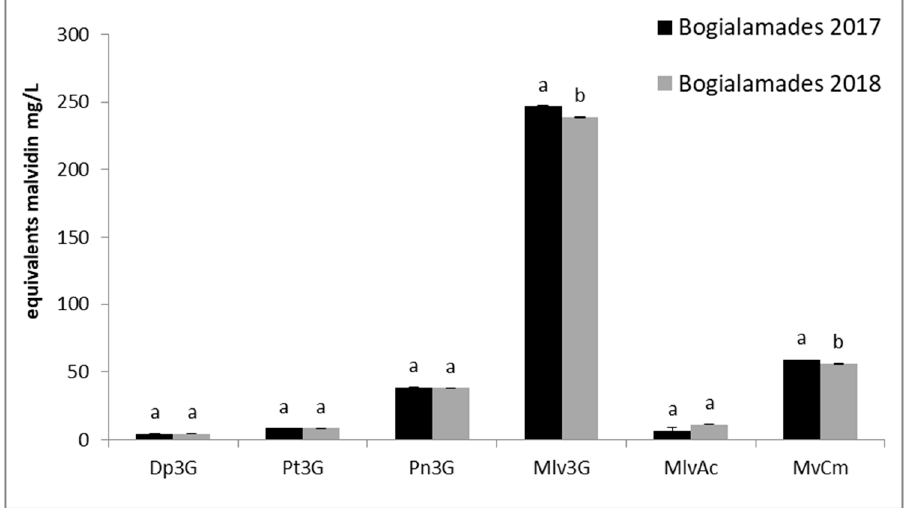
Figure 5. Individual anthocyanins evaluated by HPLC in “Bogialamades” wines. Abbreviations: Dp3G, delphinidin–3– O –glucoside; Pt3G, petunidin–3– O –glucoside; Pn3G, peonidin–3– O –glucoside; Mlv3G, malvidin–3– O –glucoside; MlvAc, malvidin 3– O –acetate–glucoside; MvCm, malvidin 3– O –coumarate–glucoside. Error bars show the average standard error. Different letters indicate significant difference between the same compounds in two consecutive years at p < 0.05 according to t